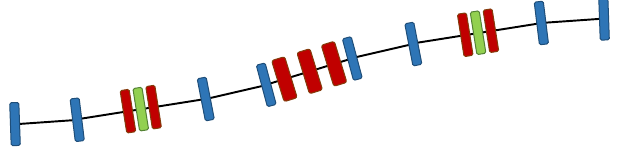
FIG. 1. Overview of the geometry of a double-achromat compressor. Blue rectangles are dipoles, red are quadrupoles and green are sextupoles. This color convention will be the same for all following figures.